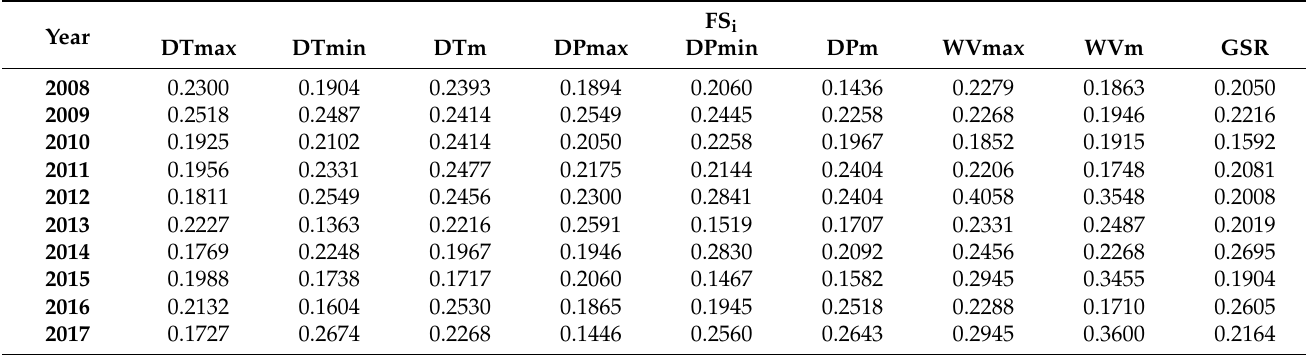
Table 2. FS values for climatic indices obtained from the Santiago EOAS station (months of January,